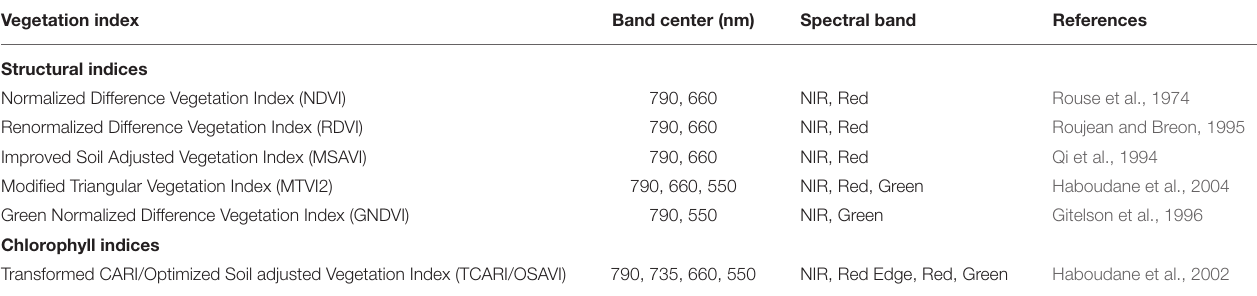
TABLE 1 | Spectral vegetation indices assessed in this